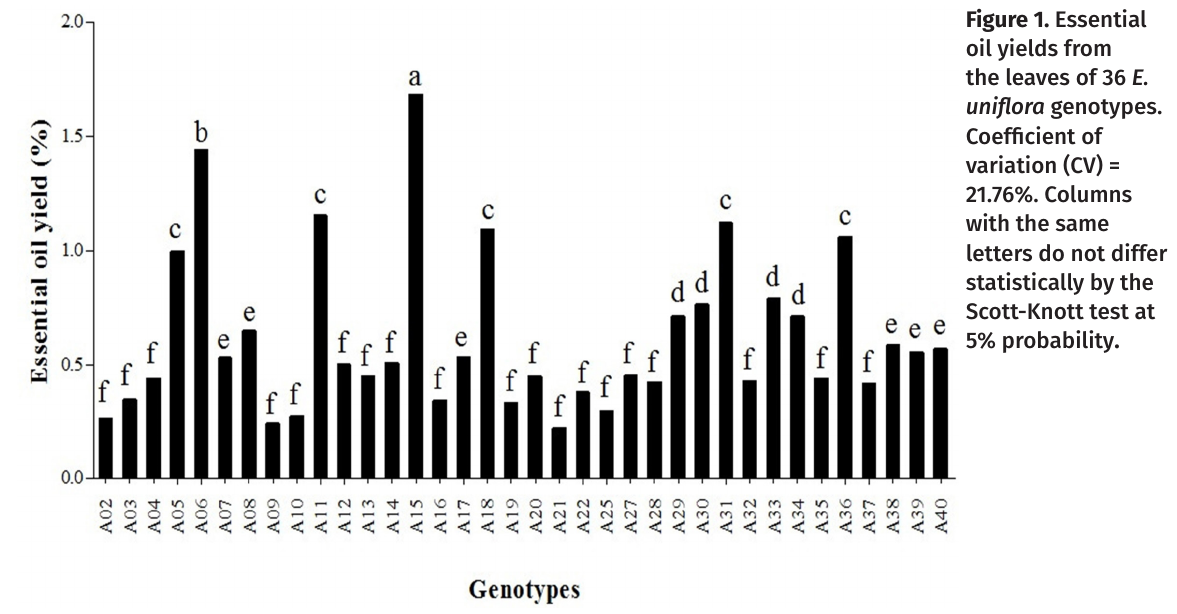
Figure 1. Essential oil yields from the leaves of 36 E. uniflora genotypes. Coefficient of variation (CV) = 21.76%. Columns with the same letters do not differ statistically by the Scott-Knott test at 5% probability